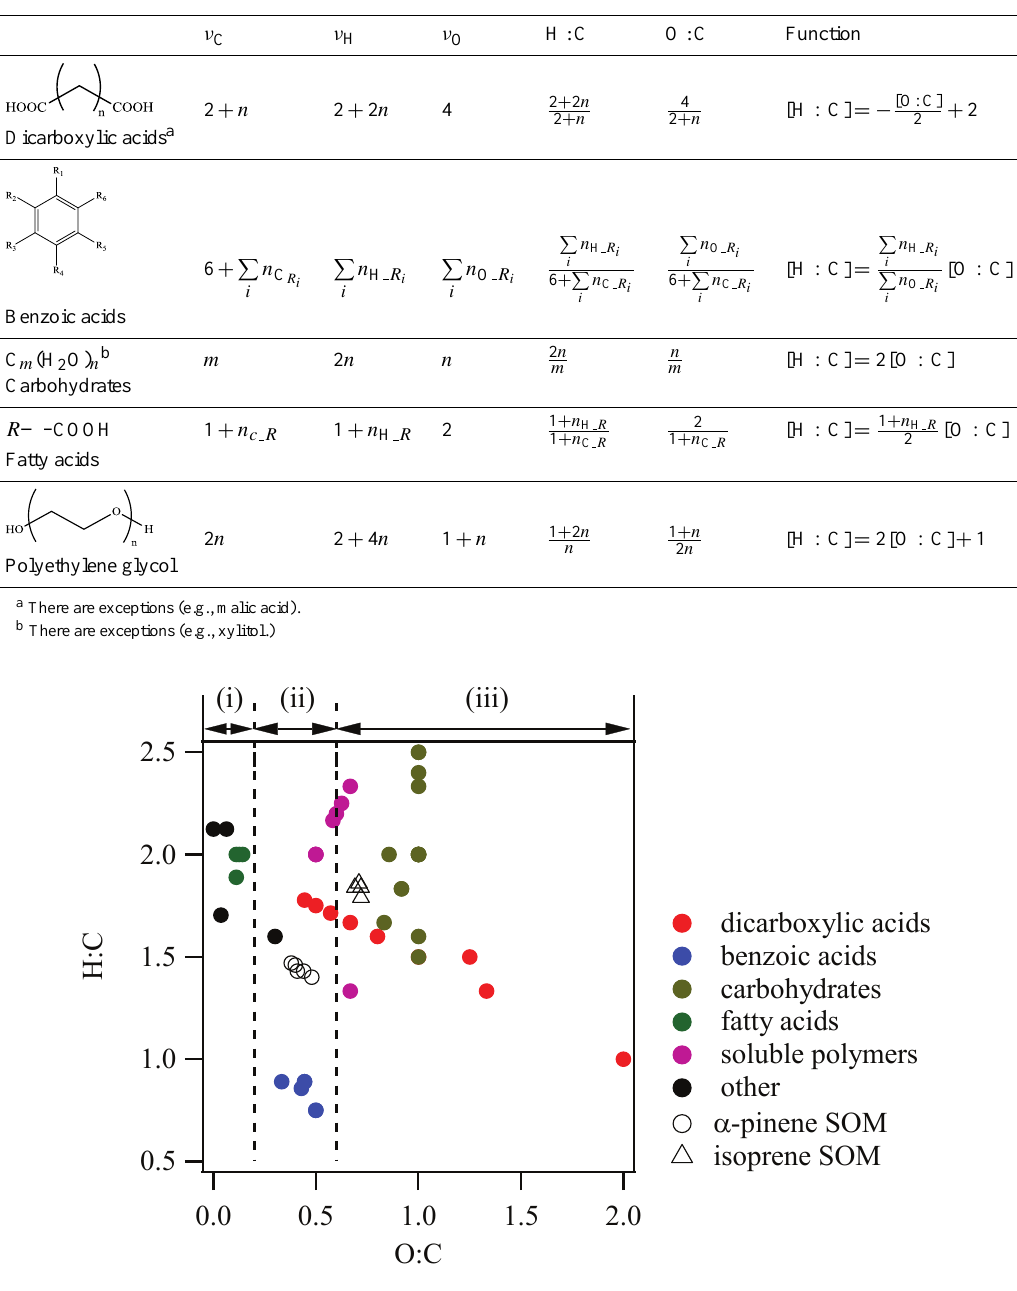
Fig. A2. Relationships between O:C and H:C ratios of pure compounds and SOM (van Krevelen diagram). The regions (i)–(iii) indicates (i) insoluble, (ii) slightly soluble, and (iii) highly soluble regimes, respectively (see the main text for detail).